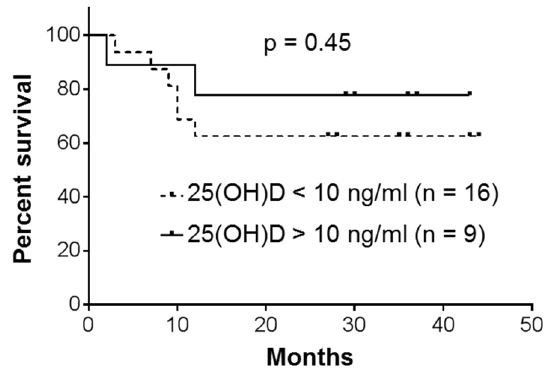
Figure 5. Overall survival of patients with chronic myeloid leukemia (CML). Kaplan–Meier analysis with a log-rank (Mantel–Cox)